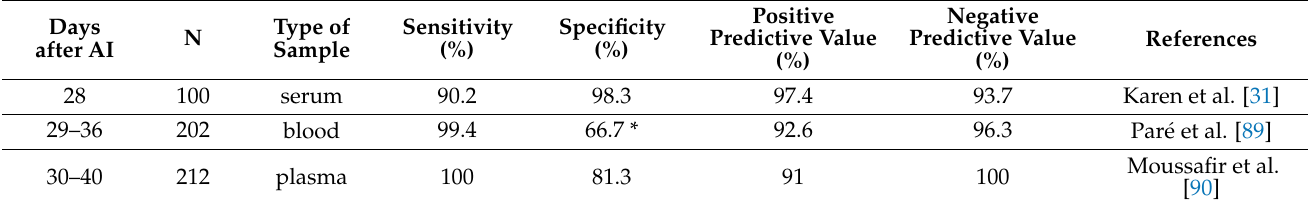
Table 6. Accuracy of commercially available D29 ® bovine blood pregnancy ELISA tests for diagnosing early pregnancy in dairy